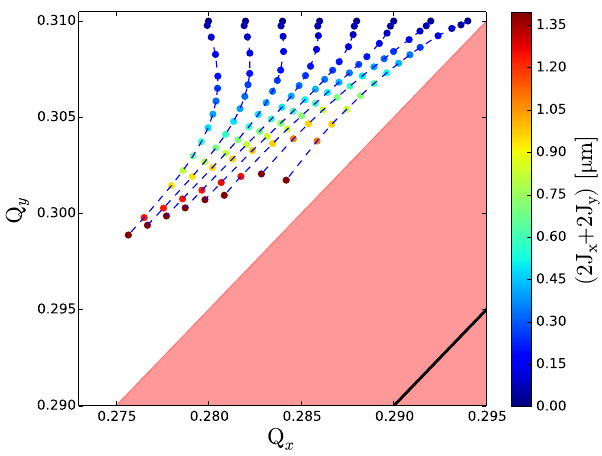
FIG. 3. Tunes from tracking with linear closest tune approach of 0.015 and nominal octupoles. The vertical kicks ranged from 0.5 mm to 4.5 mm while the horizontal were kept at 0.5 mm. The light red area delimits the linear closest tune approach of